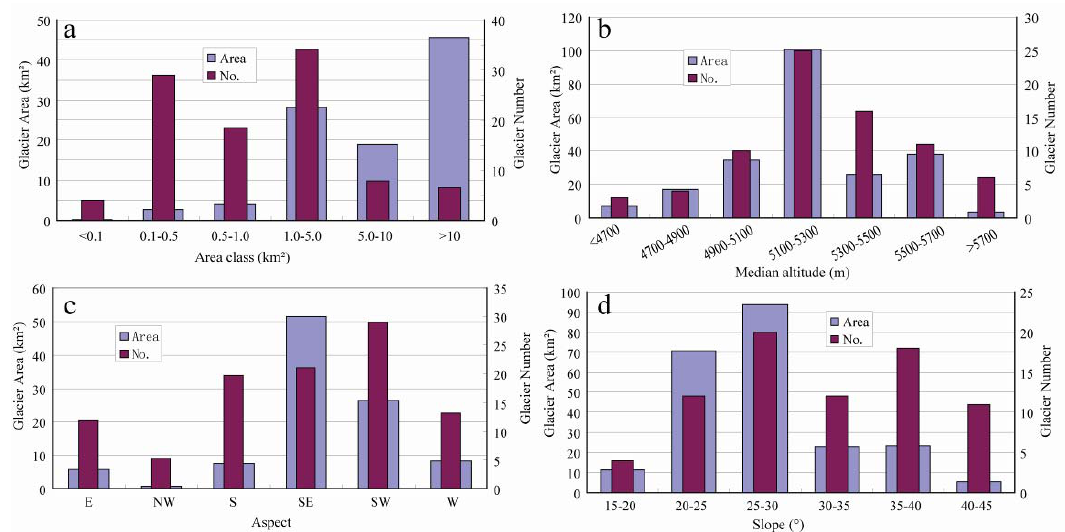
Fig. 3. Distribution of glaciers in 2009. (a) Distribution of glaciers in different area classes. (b) Distribution of glaciers by median altitude. (c) Distribution of glaciers by aspect. (d) Distribution of glaciers by mean slope.